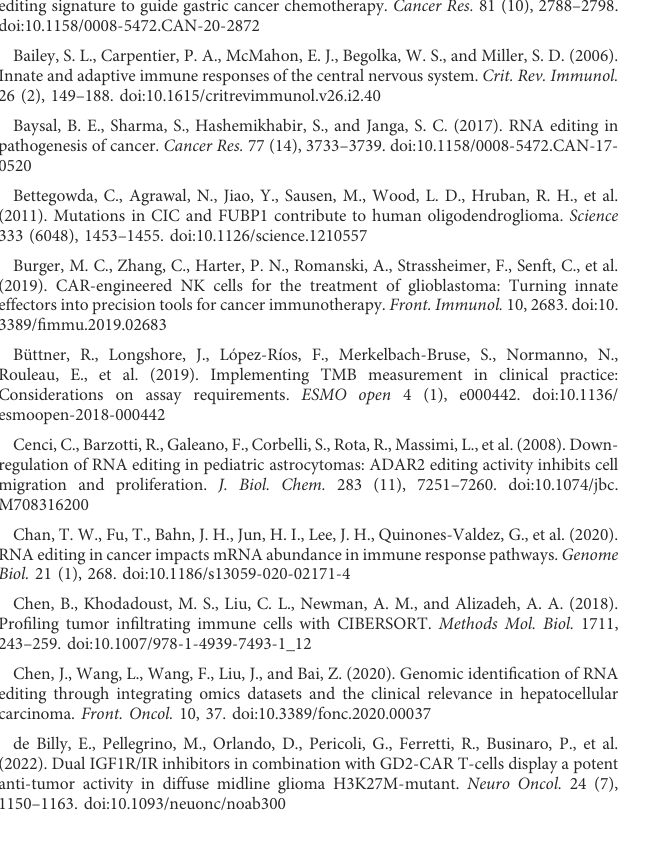
SUPPLEMENTARY TABLE S1 Thirty- fi ve PREs and corresponding coef fi cients. SUPPLEMENTARY FIGURE S1 The study work fl ow. SUPPLEMENTARY FIGURE S2 The correlation between the PREs risk signature and the prognosis of the training cohort (A, D, G) , testing cohort (B, E, H) , or overall glioma patients (C, F, I) . (A – C) The risk score distribution of patients with gliomas. (D – F) Patients survival matched to risk score distribution results. (G – I) Heatmaps showing the expression pattern of PREs between risk groups. SUPPLEMENTARY FIGURE S3 Subgroup analysis of risk score clinical relevance. The risk score variation between patients in old and grade 2,3 group vs old and grade 4 group (A) , as well as in young and grade 2,3 group vs young and grade 4 group (B) were shown in box plots. SUPPLEMENTARY FIGURE S4 Risk score variation of the wild type or mutant samples about IDH1 (A) , CIC (B) , and ATRX (C)